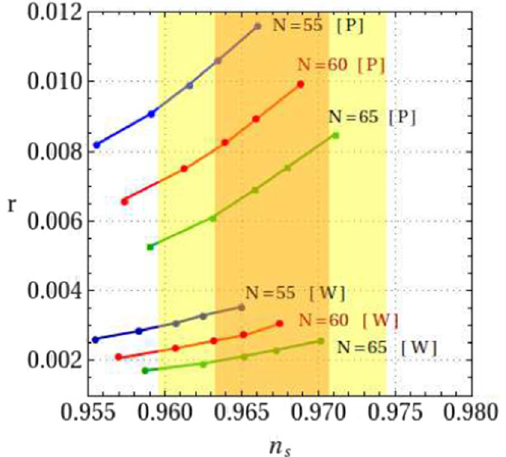
Fig. 2 The dependence r ( n s ) for various curves of constant N (as shown), for the Palatini theory ([P]) and Weyl theory ([W]). The dots stand for ξ 1 values corresponding to the curves in the last two plots in Fig. 1. The yellow (orange) area corresponds to the range measured for n s at 95%CL ( 68% ) , respectively. The curves show the largest range of values for r with λ 1 ξ 0 (cid:11) ξ 2 ; this range shrinks towards smaller r if 1 λ ξ λ ξ ∼ ξ 2 1 0 increases to 1 0